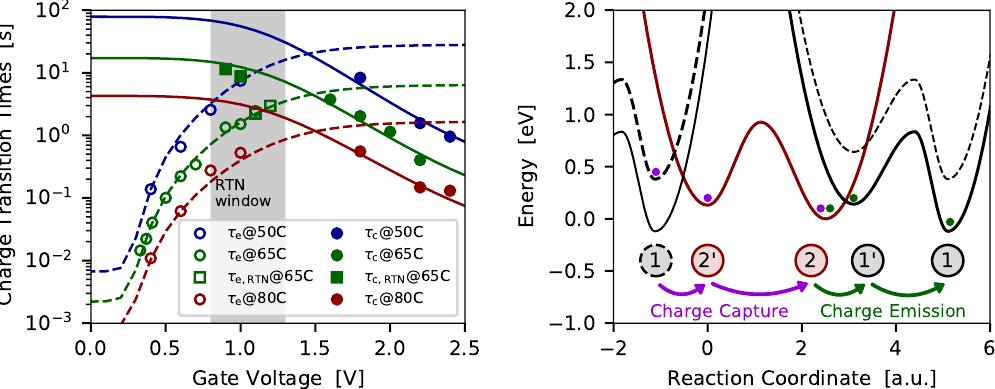
Figure 12. ( left ) The charge transition times of a switching trap shows bias dependent charge capture and charge emission times (symbols ... measurement data, lines ... simulations). ( right ) To explain the bias and temperature dependence the four state defect model is used and the corresponding approximation for the potential energy surfaces (PES) is shown. This kind of defect requires four defect states in order to properly capture the trapping